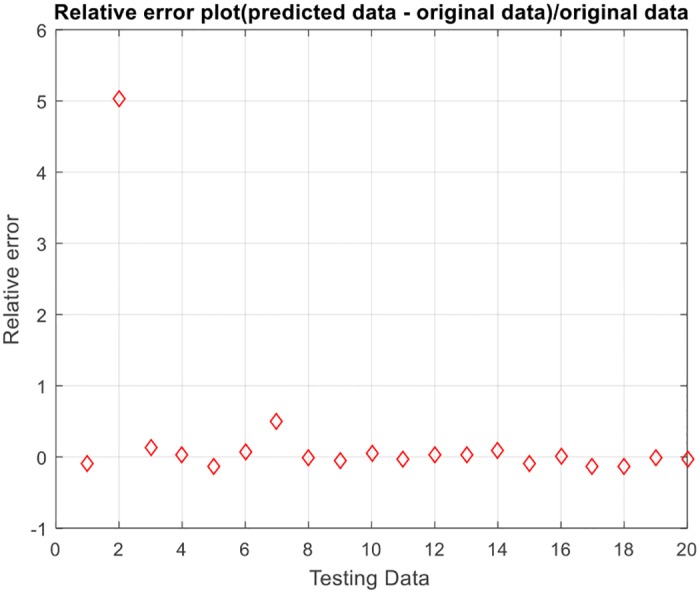
Relative error plot.